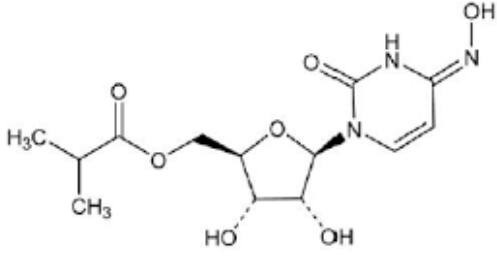
Figure 3. Structure of molnupiravir.